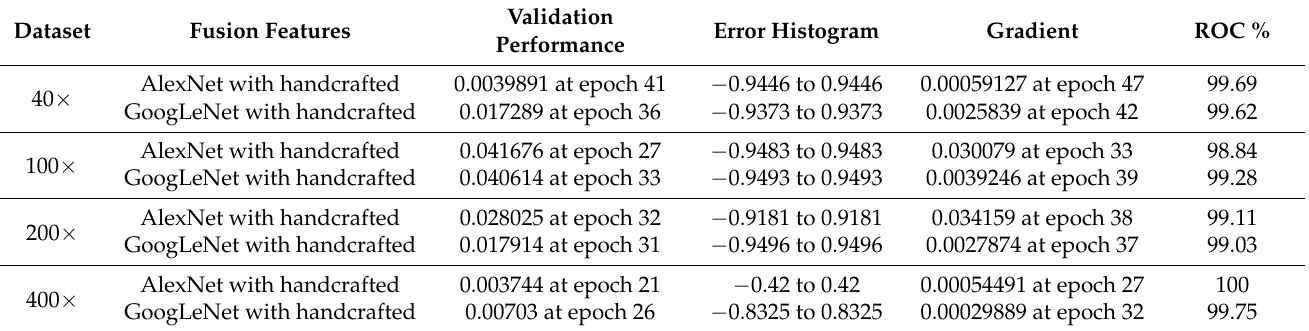
Table 5. ANN algorithm evaluation tools based on the fusion